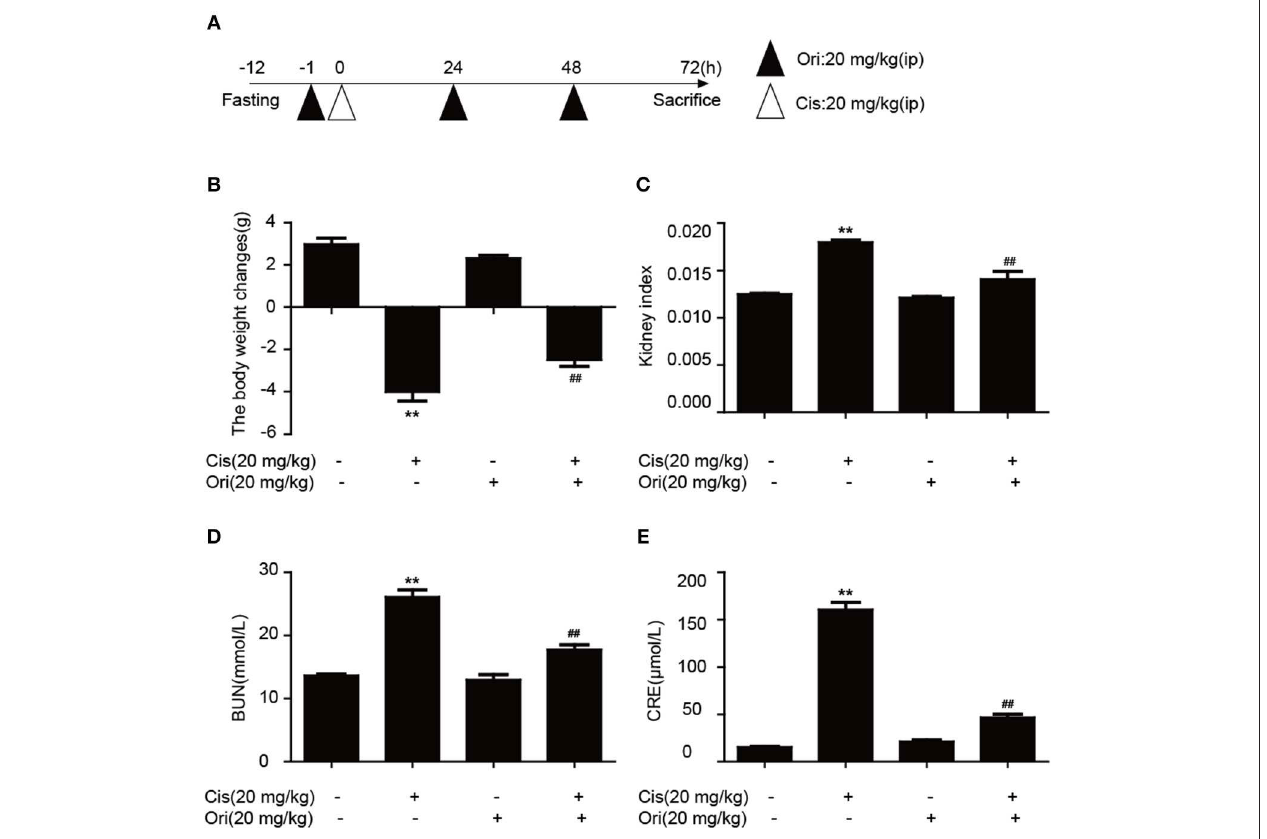
FIGURE 6 | Ori alleviates cisplatin-induced nephrotoxicity in vivo . (A) Experimental design of Ori’s therapeutic effects on cisplatin-induced kidney injury. After fasting for 12h, intraperitoneal injection of cisplatin (20 mg/kg) was performed to establish an acute kidney injury model. Ori (20 mg/kg) was administered to the enterocoelia for 3 consecutive days. (B,C) Body and kidney weights were calculated and the kidney index was shown as kidney weight divided by body weight. (D,E) Blood was collected to detect the levels of BUN and CRE. The results showed the average of three independent experiments. ** p < 0.01 vs. the control group. ## p < 0.01 vs. the Cis